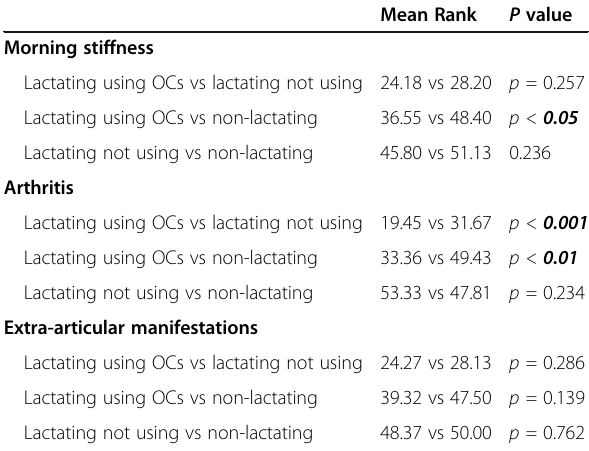
Table 2 Clinical manifestations of current, past, and non-oral contraceptives users